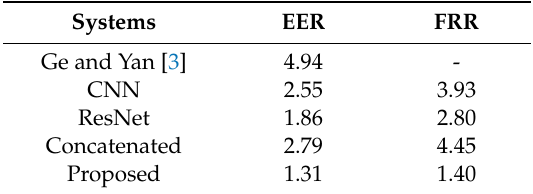
Table 7. Performance comparison of the baselines and the proposed system in EER (%) and in FRR (%) at 1.0%